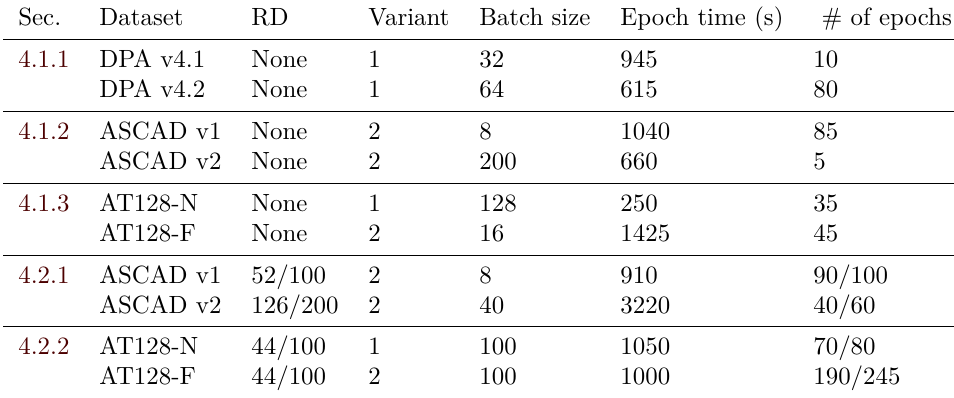
Table 2: Summary of training cost.